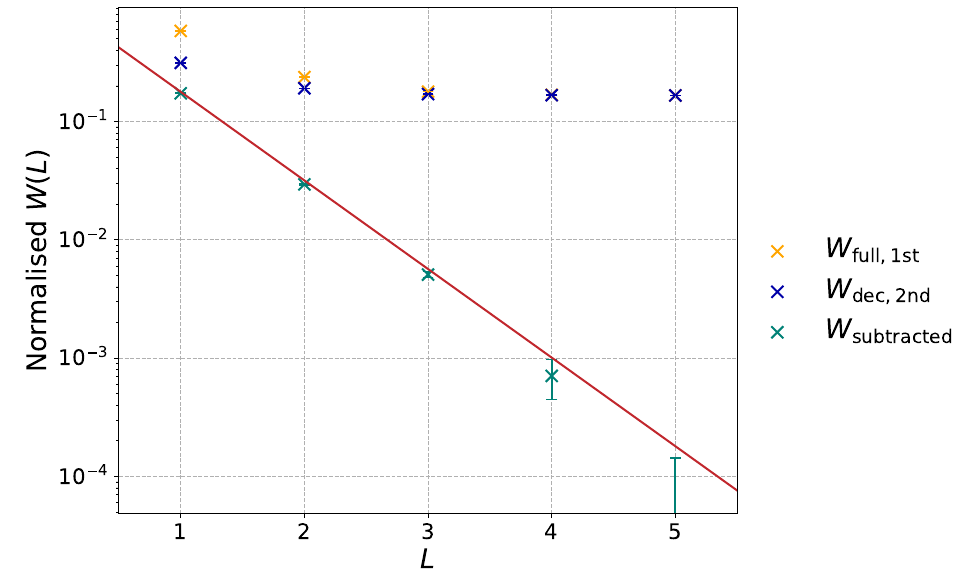
Figure 14. The complete Wilson loop from first-kind simulations, the deconfined Wilson loop from second-kind simulations, and their difference, n t = 32 and T = 0 . 29 , extrapolated to large N . Note that the continuum limit has not been